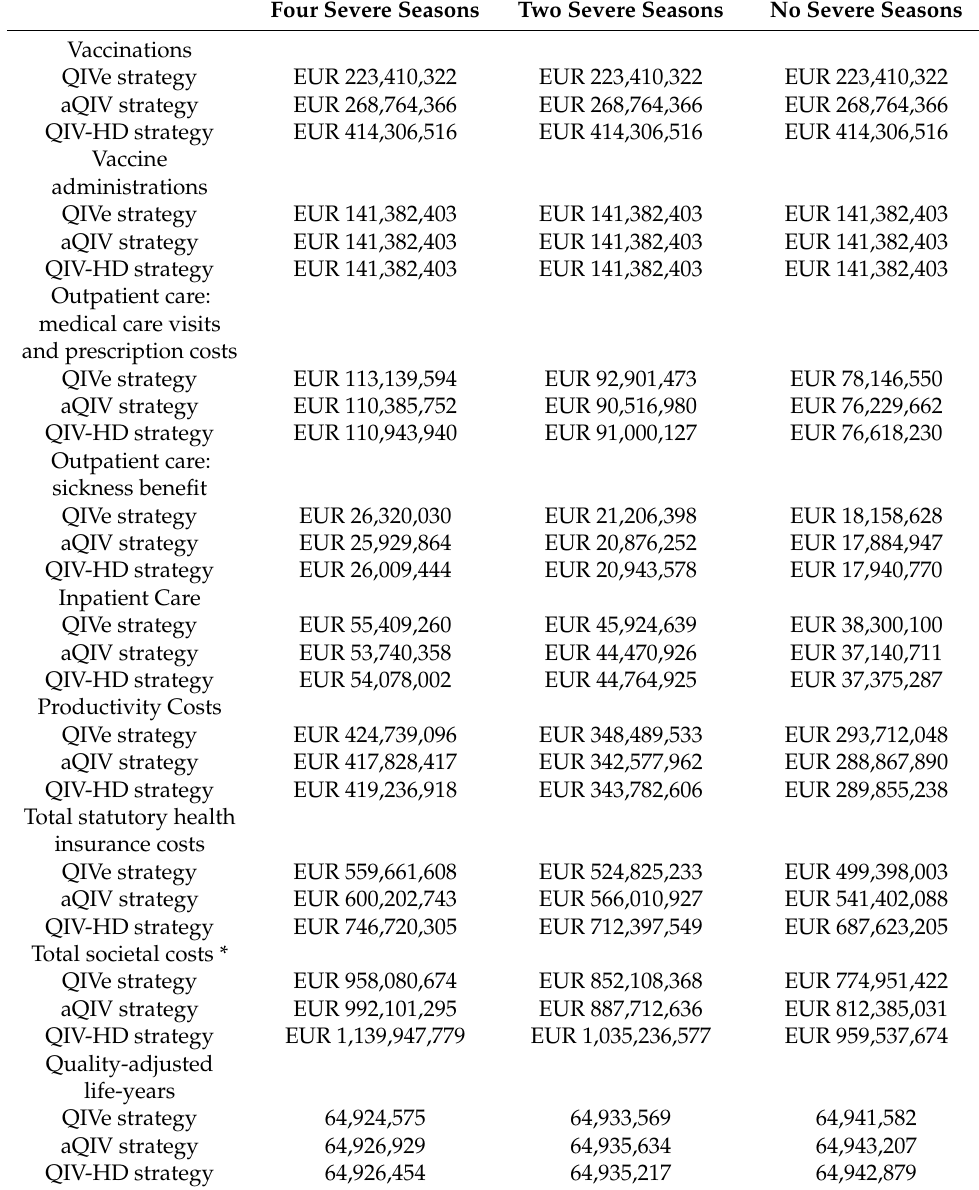
Table 4. Base case economic results: predicted average annual discounted costs and quality-adjusted life- years associated with influenza in Germany for aQIV, QIV-HD, and QIVe by number of severe